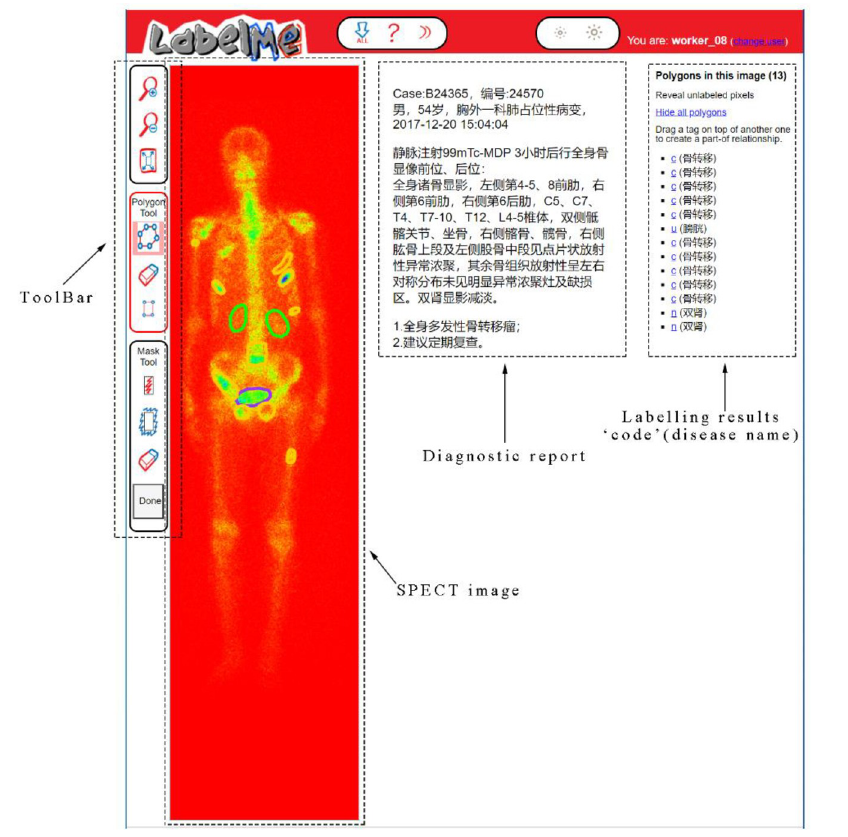
Fig 4. Labelling SPECT image using the LableMe based annotation system.